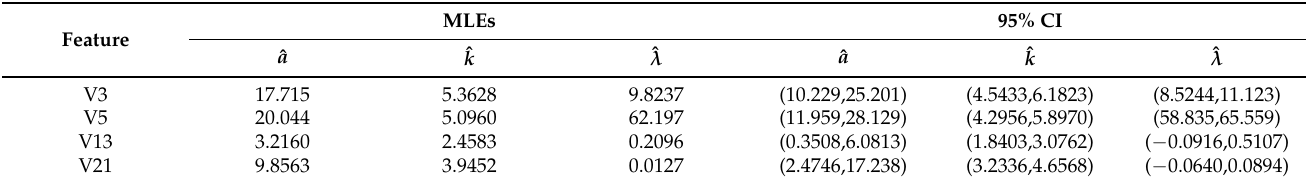
Table 5. MLEs and 95% CIs of the MPoF parameters.